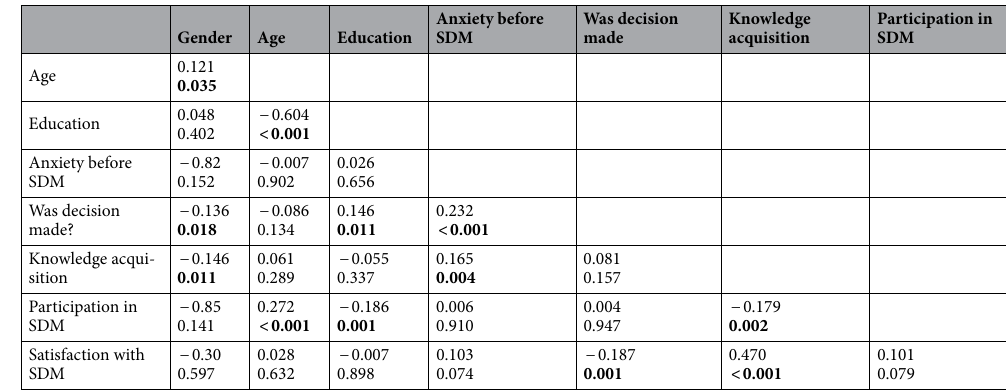
Table 3. Pearson correlation coefficients of the variables involved in the shared decision-making process. Gender: 1: male; 0: female. Age: 1: < 39 years; 2: 40–59 years; 3: ≥ 60 years. Education: 1: Elementary school; 2: high school; 3: College/university and above. Anxiety level before SDM: 1: None; 2: Slight; 3: Average; 4: Moderate; 5: High. Was decision made: 1: Not yet; 2: Yes. Knowledge acquisition: 1: Strongly disagree; 2: Disagree; 3: Average; 4: Agree; 5: Strongly agree. Participation in SDM: 1: Patient only; 2: With family. Satisfaction with SDM: 1: Very unsatisfied; 2: Unsatisfied; 3: Average; 4: Satisfied; 5: Very satisfied. Significant P values are in